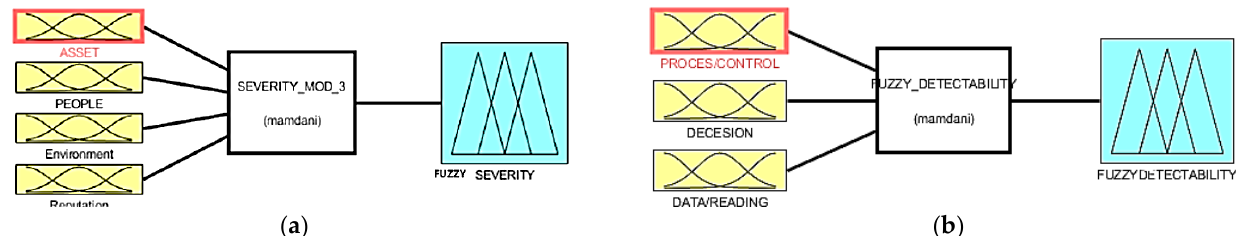
Figure 4. Fuzzy Inference Systems structure: ( a ) Severity FIS; ( b ) Detectability FIS.